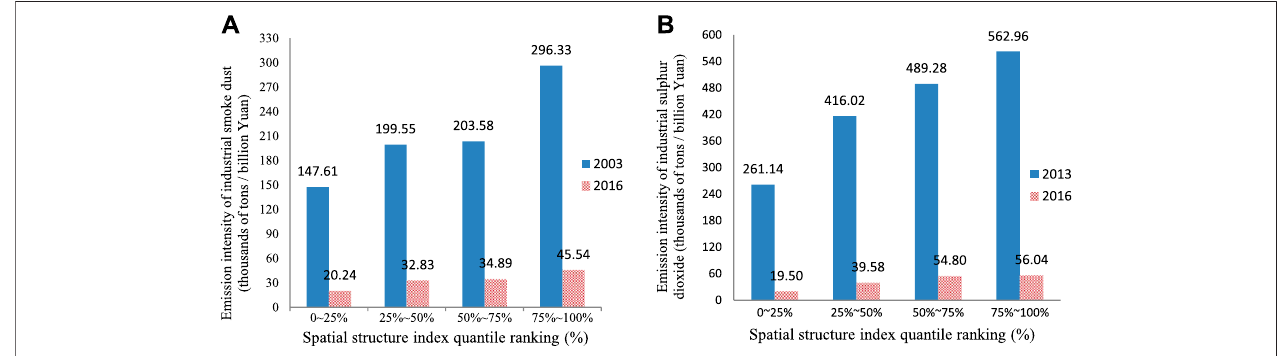
FIGURE 1 | Spatial structure of city-region and pollution emission intensity in 2003 and 2016. The ordinate label in the charts have indicated the difference between (A,B)